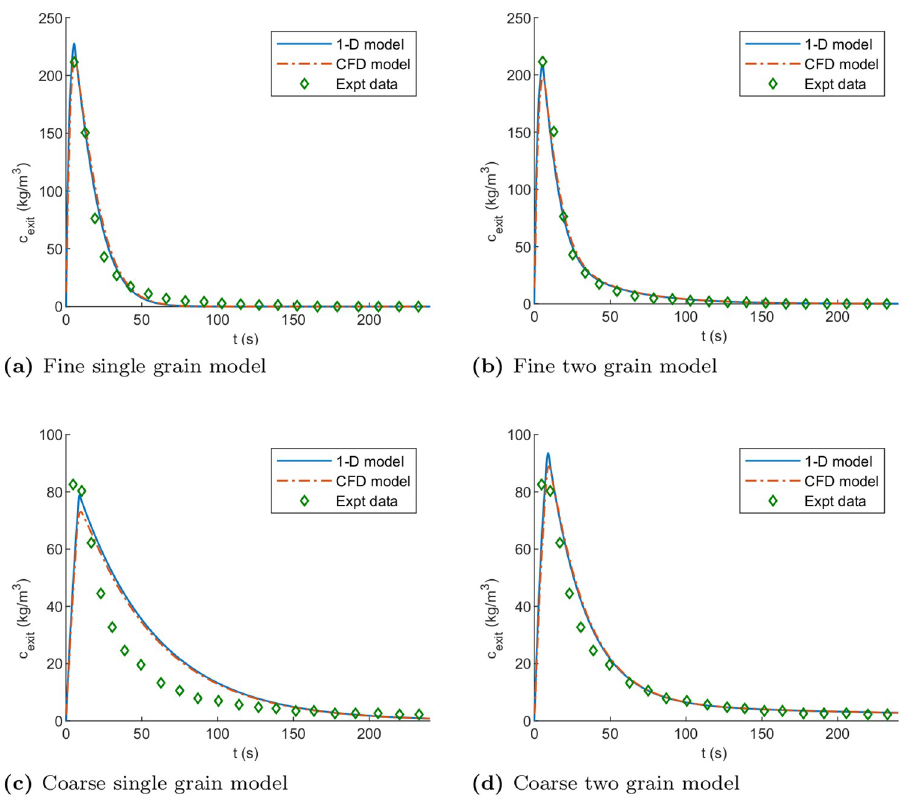
Fig 6. Numerical and experimental results cylindrical case. Comparison between experimental (Expt data) and numerical outlet coffee concentrations for different models for the fine grind ((a) and (b)) and the course grind ((c) and